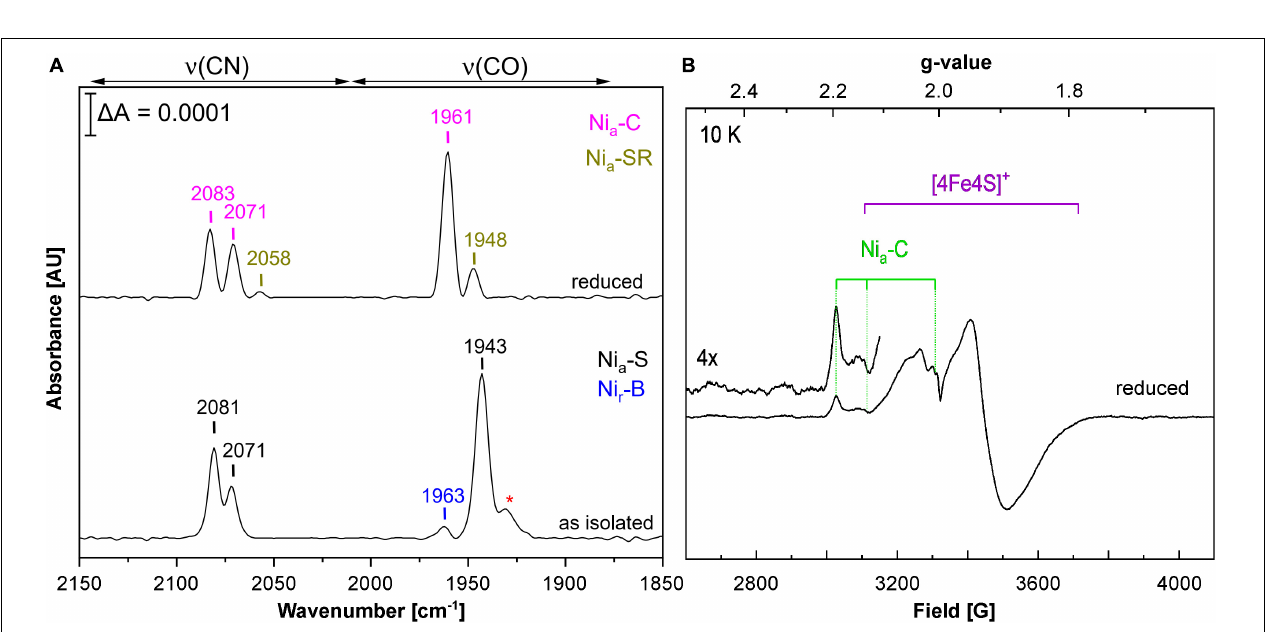
FIGURE 3 | Spectroscopic characterization of RH heterologously produced in E. coli. Spectroscopic data were recorded on RH purified from MQF8RH2 (30 ◦ C/0.5 mM NiCl 2 ). (A) IR spectra of as-isolated and H 2 -reduced RH. The signals indicate the presence of CO and CN ligands of the NiFe(CN) 2 CO active site. Bands are labeled according to the different redox states of the RH (Ash et al., 2015; Roncaroli et al., 2015; Caserta et al., 2020), i.e., Ni a -S (2,081, 2,071, 1,943 cm − 1 ), Ni r -B (2,097, 2,089, 1,963 cm − 1 ), Ni a -SR (2,073, 2,058, 1,948 cm − 1 ), and Ni a -C (2,083, 2,071, 1,961 cm − 1 ). The red asterisk most likely indicates traces of Ni r -S species (1,931 cm − 1 ). (B) EPR spectrum of sodium dithionite (Na 2 S 2 O 4 )-reduced RH. The spectrum was recorded at 10 K and a microwave power of 1 mW.